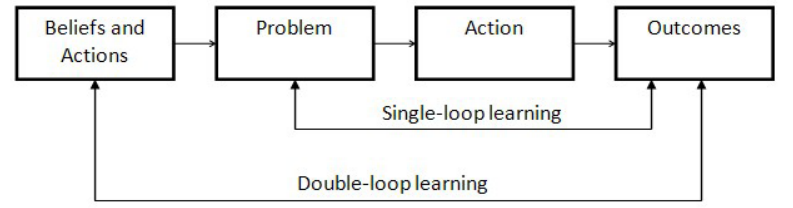
Figure 1. Double-loop learning (Eberle & Childress, 2005, as shown in Eberle, 2009, p.